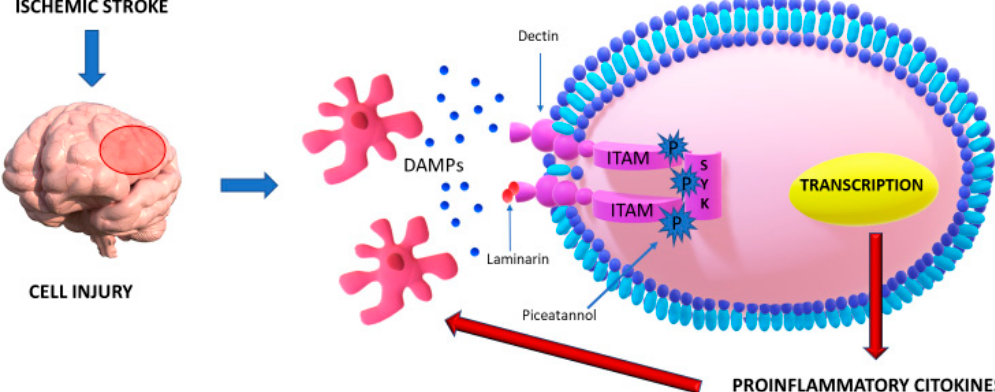
Figure 2. Dectin-1, also known as Dendritic cell-associated C-type lectin-1, a receptor activated by the interaction with DAMPs (damage-associated molecular patterns), is responsible for an innate immune response when brain damage such cerebral ischemia occurs. The crosstalk between Dectin-1 and DAMPs determines phosphorylation of ITAM and, subsequently, of Syk, a kinase which mediates a cascade of neuroinflammation and the release of several cytokines. Some antagonist molecules of Dectin-1 like Syk inhibitor piceatannol and laminarin can underregulate this process, reducing the detrimental effects of neuroinflammation on brain damage after a stroke.